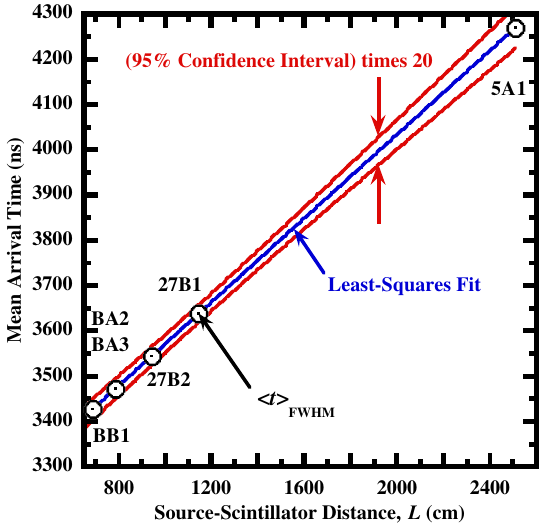
FIG. 7. Least-squares fit to the raw, mean arrival data h t i FWHM for the six nTOF detectors in shot 2584. Shown (red lines) are the corresponding 95% confidence intervals (CI) for the fit at an arbitrary distance. The CI numbers have been magnified by a factor of 20 to be visible on this scale. Data channels (Table I) are noted. The fits to raw t and t arrival times are identical on Mode smoo this scale.